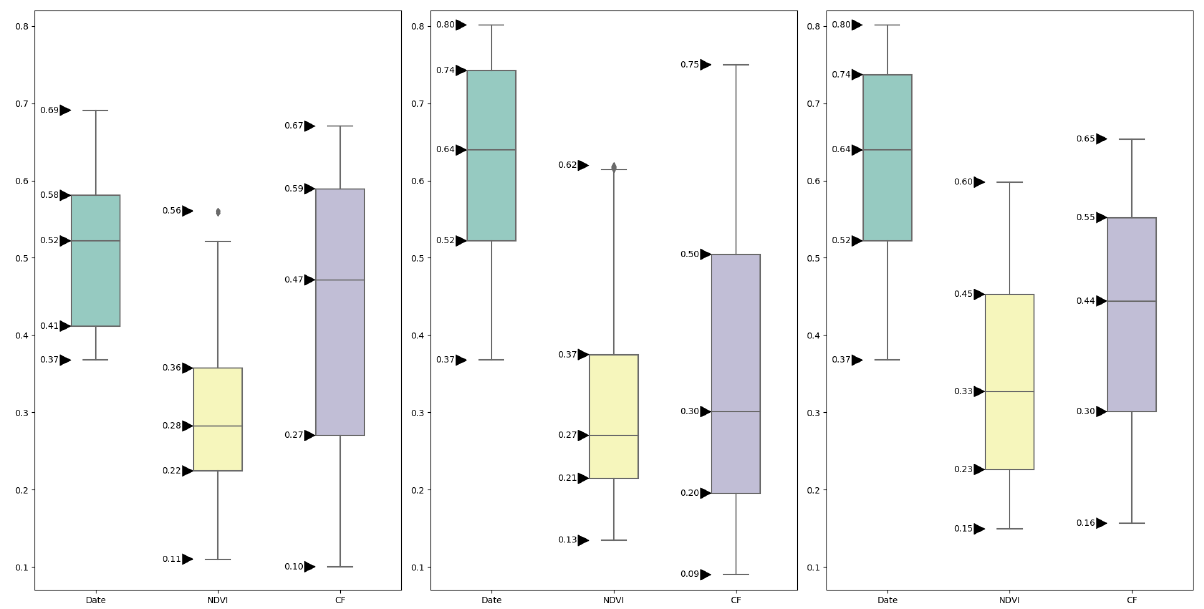
Figure 6. On the left, the boxplots of the ground truths of Fields B, C, and D on which the KDE was fit. In the middle, the generated labels by the KDE for Field A and, on the right, the ground truth boxplots of Field A. Date and CF dimensions were rescaled to 0–1 to match the NDVI data range. The dates 0 and 1 correspond, respectively, to the 1st of June and the 15th of October. CF rescaled linearly from 0–10,000 to the 0–1